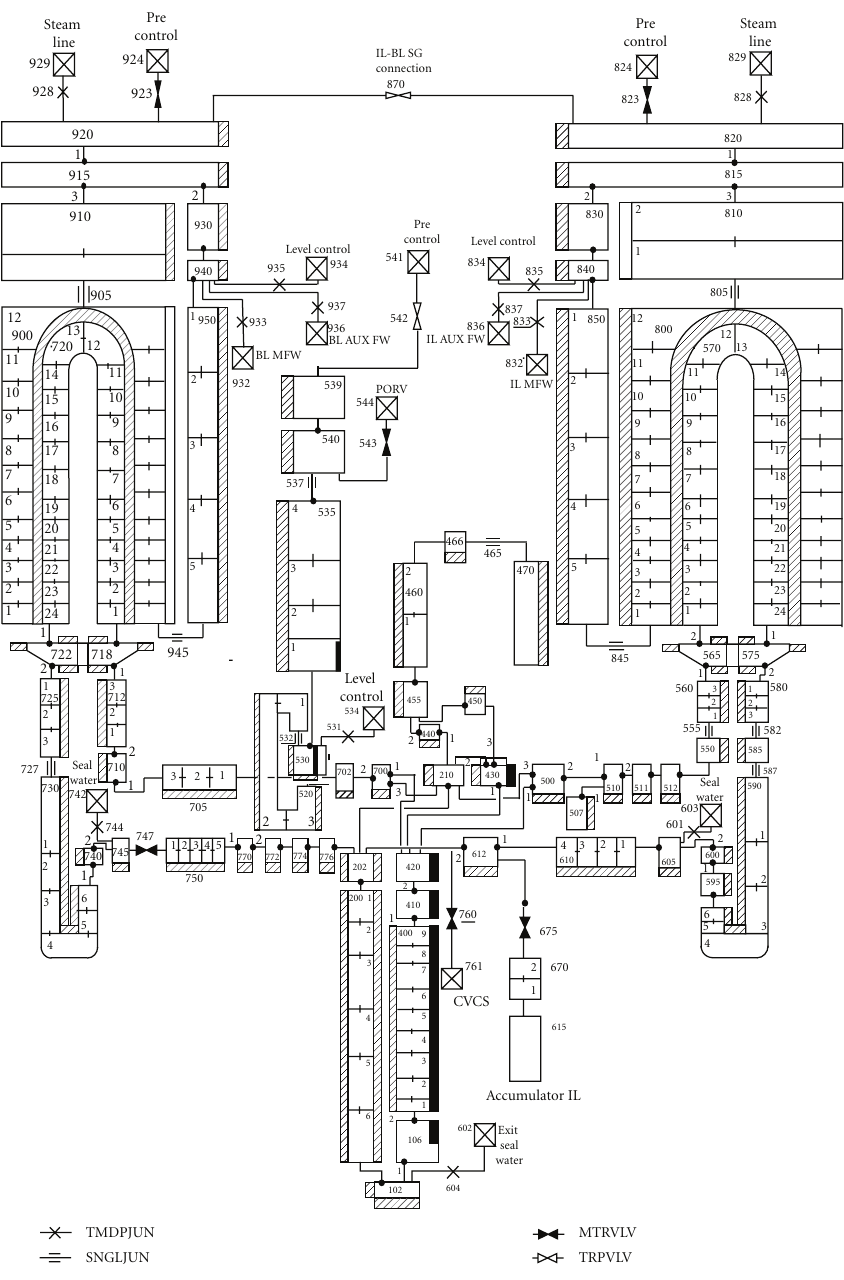
Figure 2: LOBI-MOD2 nodalization for relap